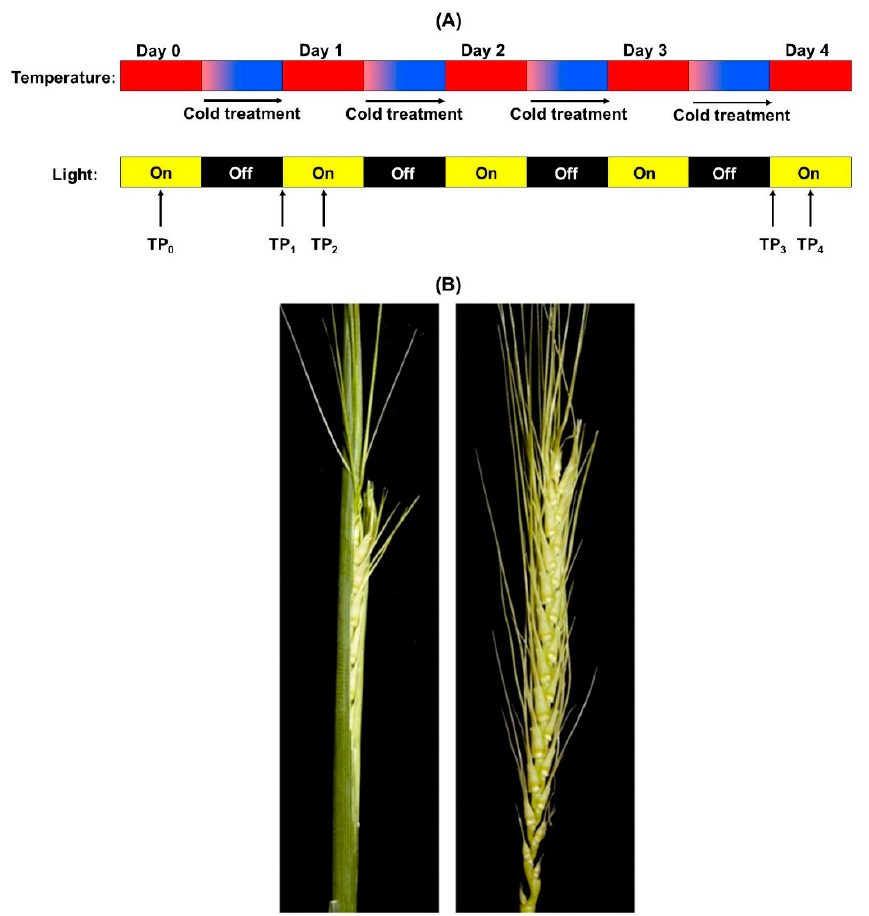
Figure 1. ( A ) Schematic diagram showing the controlled environment design of the cold treatments and lighting conditions (see Section 2.1). Yellow bars show day-light conditions, black bars dark conditions. Arrows labelled TPx indicate where samples were harvested from wheat plants. ( B ) Pictures showing the morphological stage of the young microspore (YM) stage wheat spikes used in this study. At the YM stage, wheat spikes have been shielded from light exposure by the surrounding leaf sheaths (left picture). The picture on the right shows the dissected spike used for metabolite measurements.